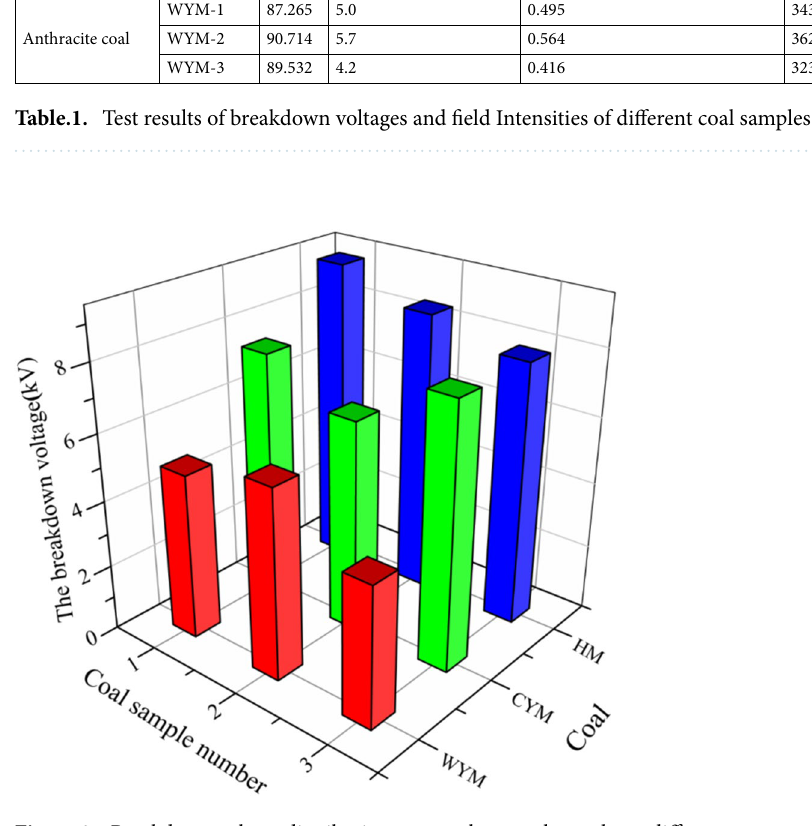
Figure 2. Breakdown voltage distribution among three coal samples at different metamorphic